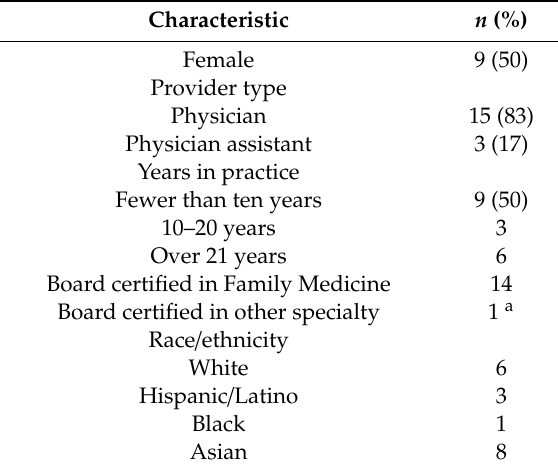
Table 1. The characteristics of the primary care